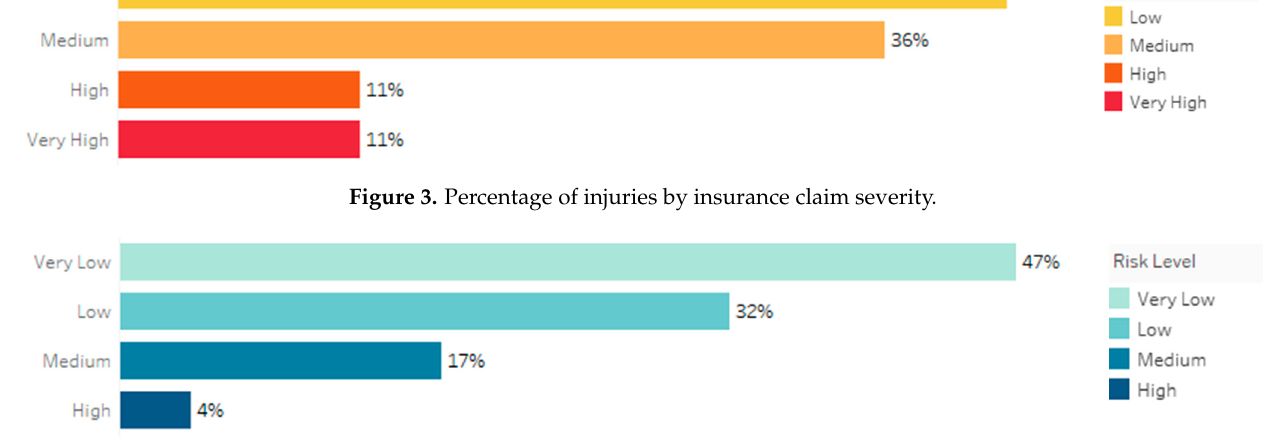
Table 3. Contingency table of injury severity classifications.